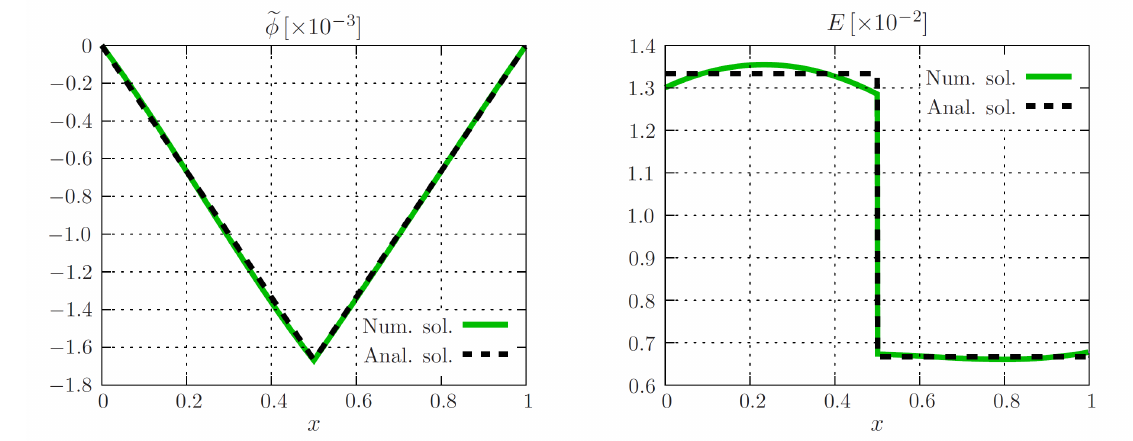
Figure 4. Numerical vs. analytical solution for 2 SLPs with 10 neurons each and a random initialization of p ( 0 ) ∼ U ( 0,1 ) , where U ( 0,1 ) denotes a vector of numbers generated from a uniform distribution between 0 and 1. These parameters are statistically